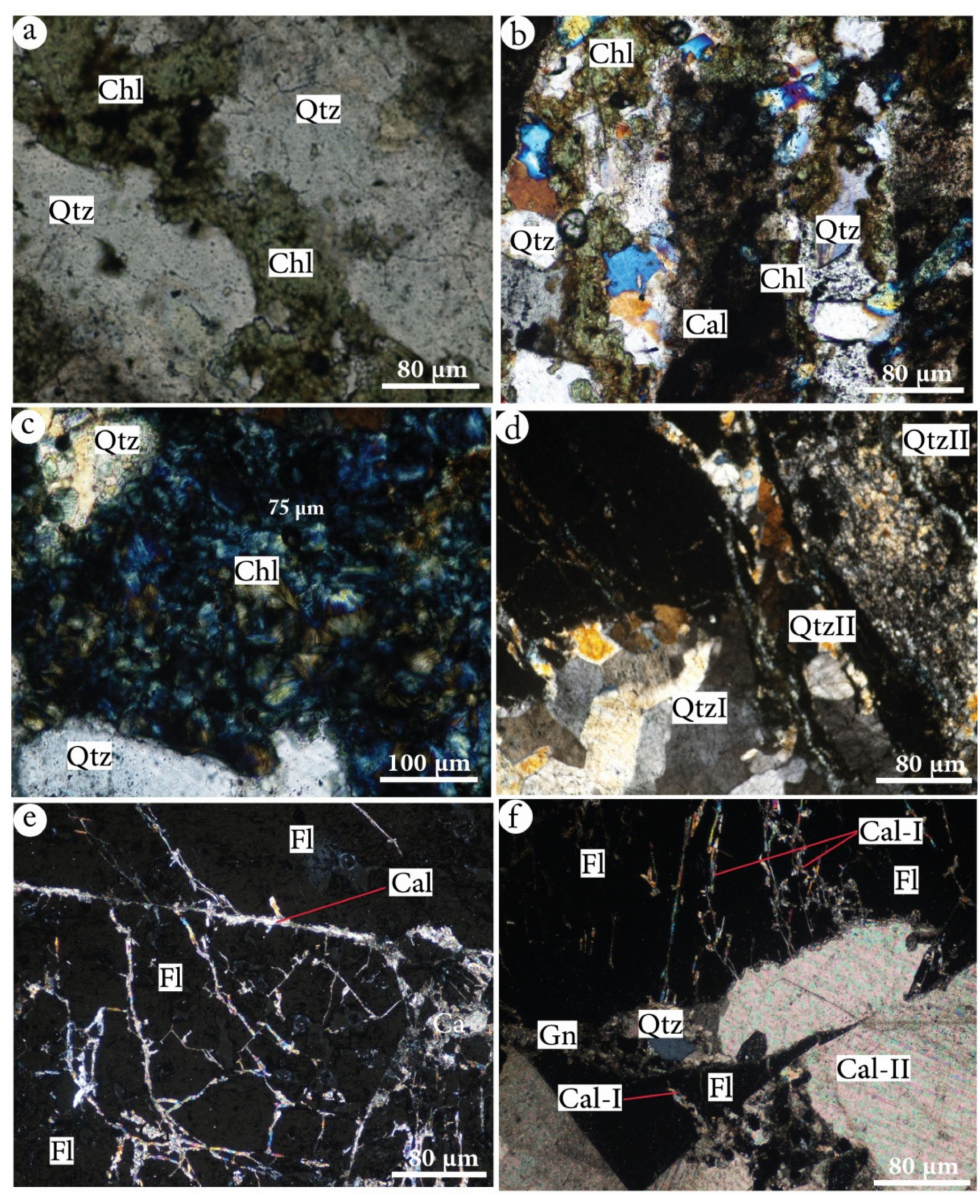
Figure 13. Microphotographs of different generations of quartz in association with chlorite, calcite, and fluorite (cross nicols, except for ( a ) where nicols are parallel). ( a , c ) Late veins of chlorites intersecting early veins of quartz; ( b ) calcite developed veins intersecting early quartz veins; ( d ) late quartz veins that crosscut the early veins; ( e ) late calcite veins intersecting fluorite; ( f ) calcite II developed in late veins and intersecting early veins of calcite I. Chl: Chlorite; Cal: Calcite; Fl: Fluorite; Qtz: